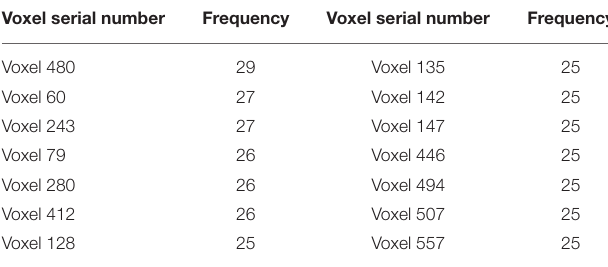
TABLE 2 | The important abnormal hippocampal voxels with frequency greater than